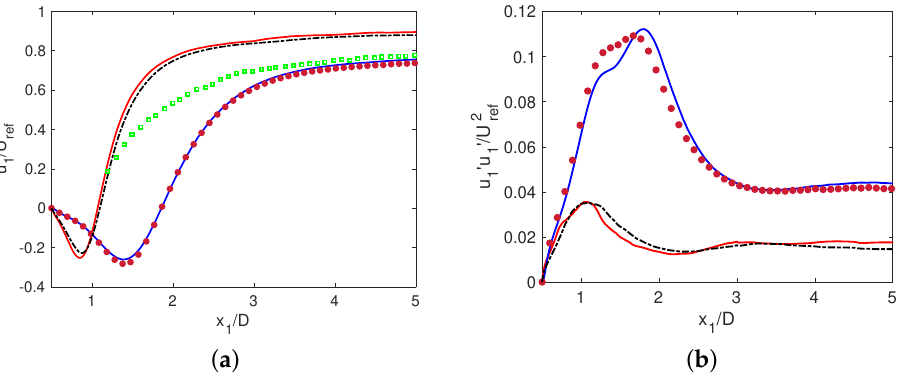
Figure 6. ( a ) Stream-wise velocity and ( b ) its fluctuations in the wake centerline. Comparison with sub-critical and super-critical results. The red solid line present the results; (black dash-dot line) Re = 7.2 × 10 5 [16]; (blue line) Re = 3900 [15]; (purple circles) Re = 5000 [34]; (green squares) Re = 1.4 × 10 5